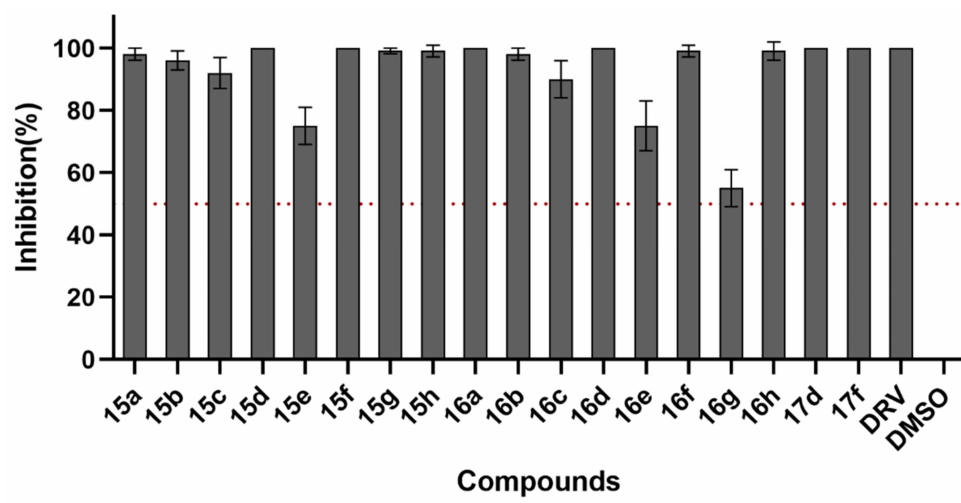
Figure 4. Effects of inhibitors on late-stage HIV-1. All assays were conducted in triplicate, and the data shown represent mean values ( ± SD) derived from the results of three independent